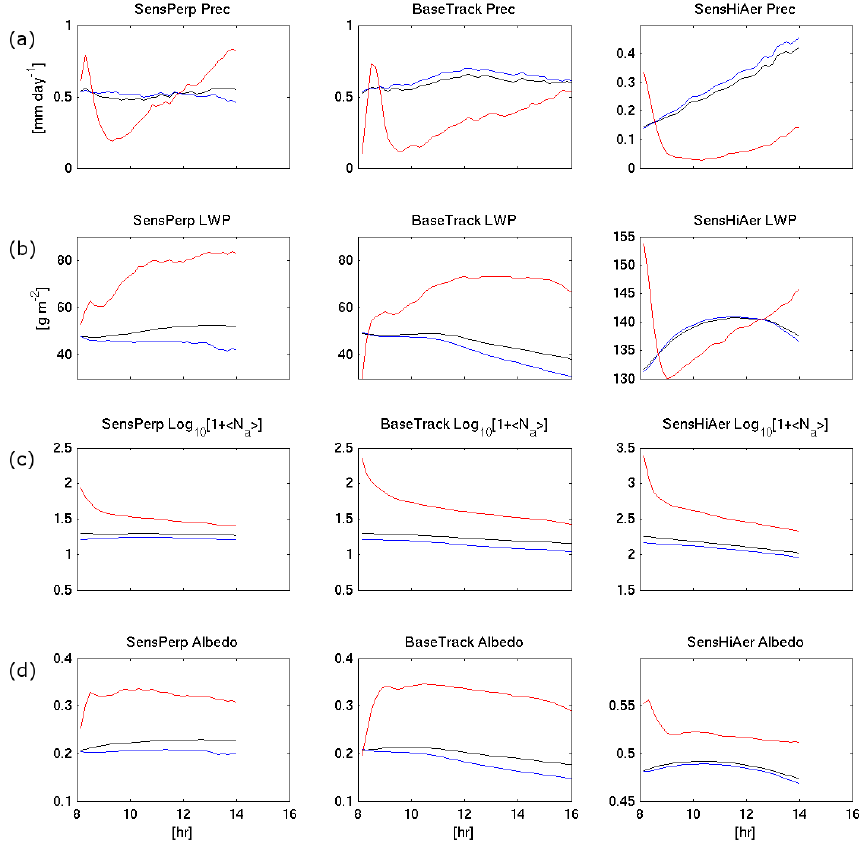
Figure 15. Track (red line), background (blue line), and domain (black line) averaged time series for runs SensPerp (first column), BaseTrack (second column), and SensHiAer (third column). Plotted are (a) surface precipitation rate, (b) LWP, (c) (cid:104) N a (cid:105) , and (d) albedo.